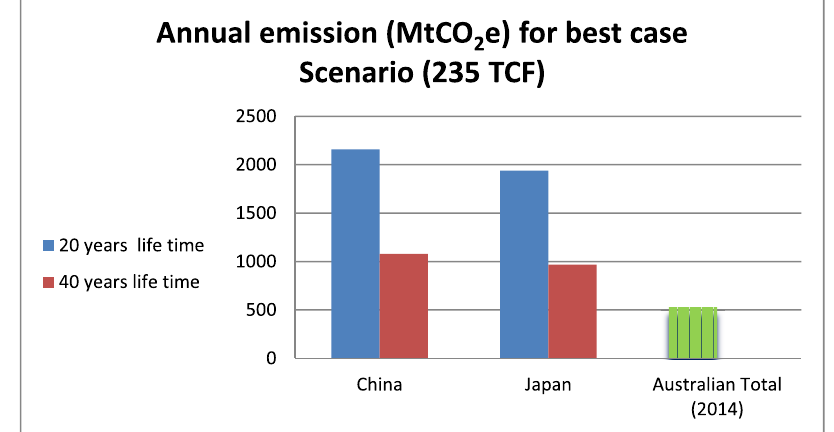
Fig. 7. Comparison with Australia ’ s national GHG emissions (2014) in best case scenario.